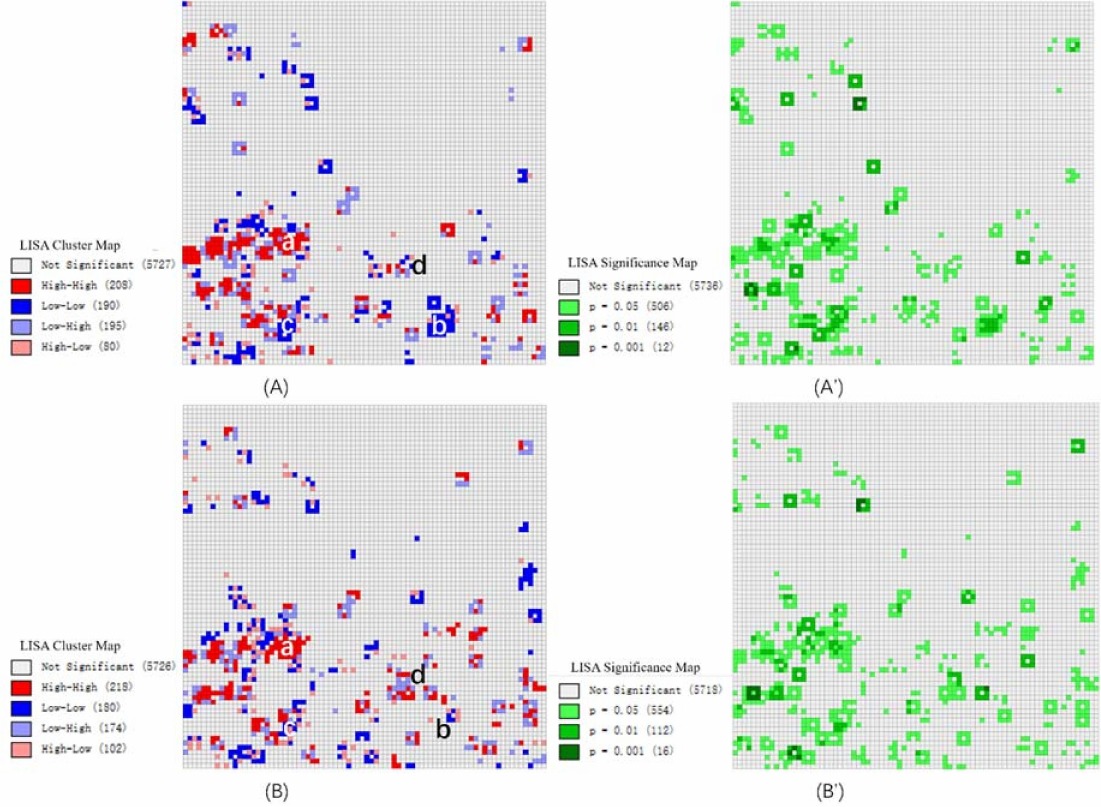
Figure 6. The local indicators of the spatial association cluster pattern of ( A ) the difference between the number of female users and male users on weekdays and ( B ) the difference between the number of female users and male users on weekends. ( A’ , B’ ) are the local indicators of the spatial association significance map ( p <